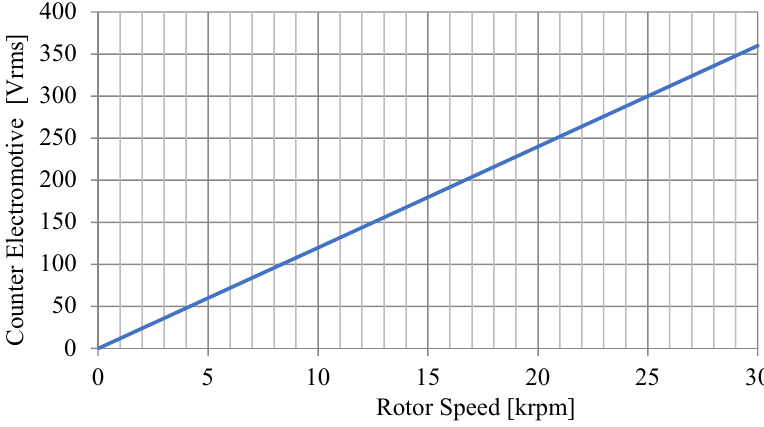
Figure 9. The change in Back-EMF versus rotor speed.